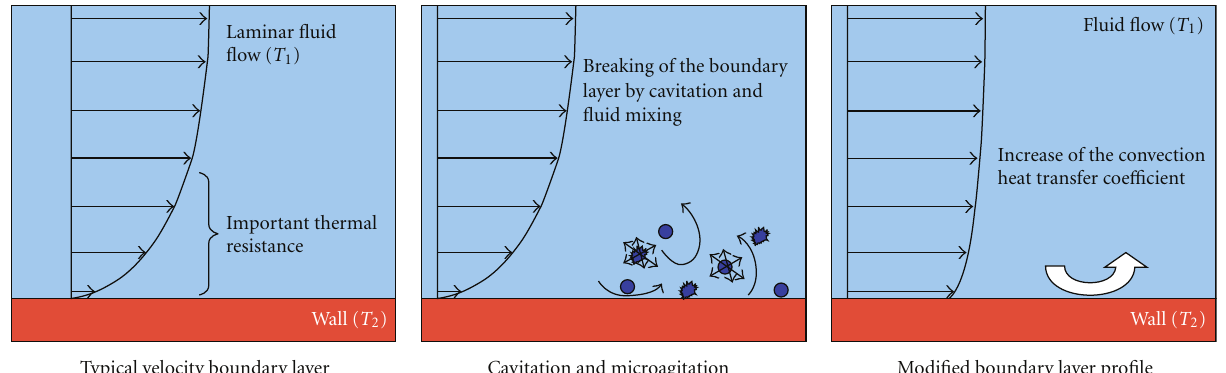
Figure 4: Explanation of heat transfer enhancement by acoustic cavitation.